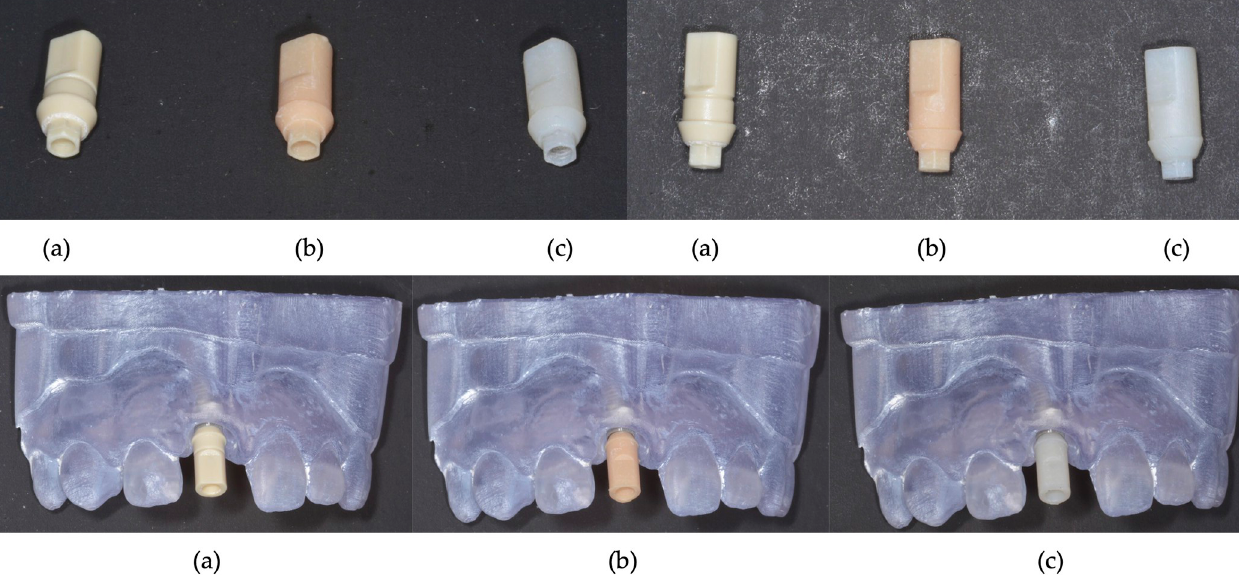
Fig 2. Scan bodies: (a) manufacturer’s scan body; (b) SLA printed scan body; and (c) DLP printed scan body, both lone standing and in dental cast.